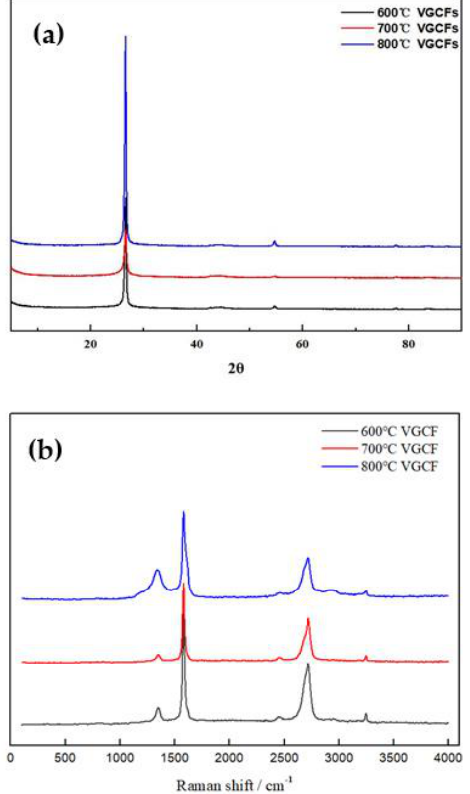
Figure 4. ( a ) XRD spectra of VGCF prepared at different temperature. ( b ) Raman spectra of VGCF prepared at different temperature. Table 1. The ratio of the integrated value of the D-band and the integrated value of the G-band of carbon fiber at different deposition temperatures: I D :I G .